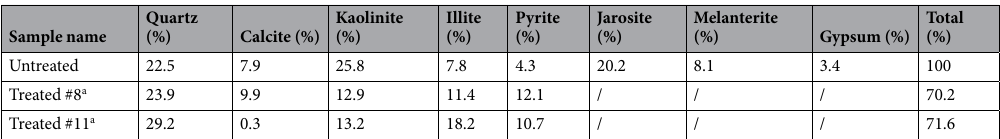
Table 2. XRD result for untreated and bioconverted coals. a The percentage of mineral matters for two treated coals were normalized by carbon content and the disappearance of jarosite, melanterite and gypsum